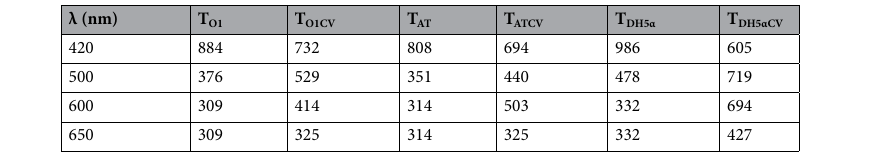
Table 2. Theoretically estimated maximum temperatures of unstained and stained E. coli strains versus irradiation wavelength. Here, the temperatures were denoted in units of absolute temperature